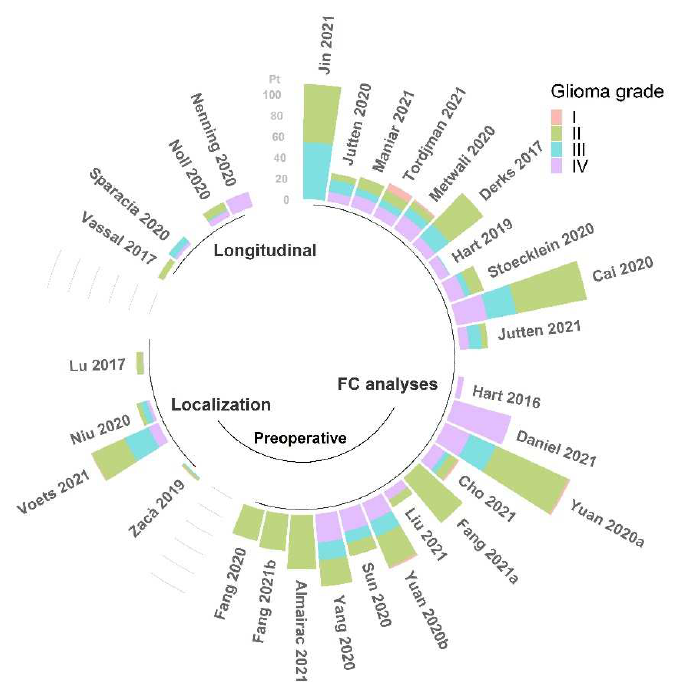
Figure 4. Number of patients (pt) with classified WHO grade glioma among the studies (N = 30) reviewed for this work [22,24,25,27,29–38,40–52,54–56], grouped by field of application, and reported in order of citation. This information was not available for the other 5 studies